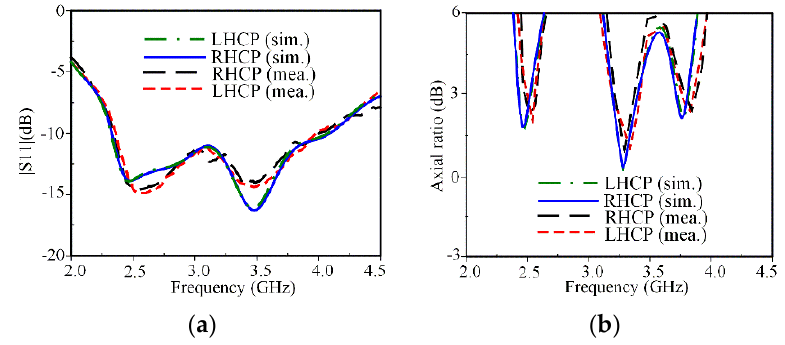
Figure 10. Measured results for both CP states: ( a ) S11; ( b ) axial ratio.